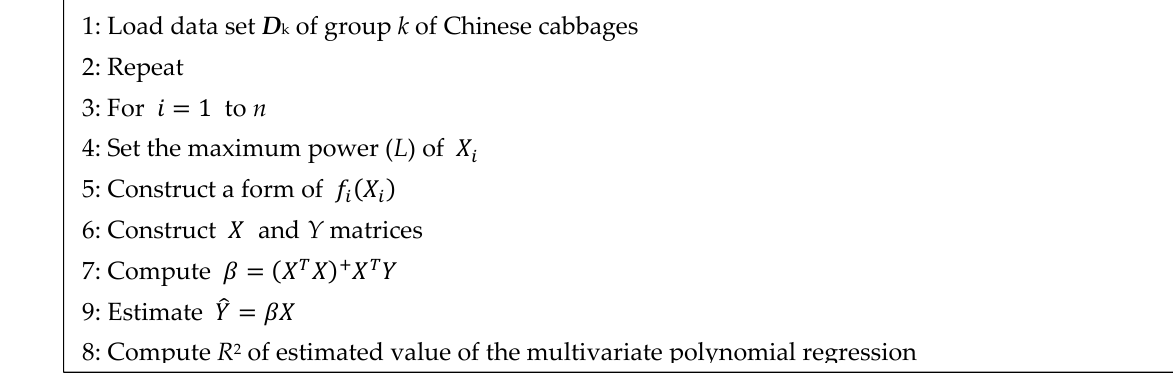
Figure 4. Pseudo code of the MPR with the Moore–Penrose pseudoinverse.